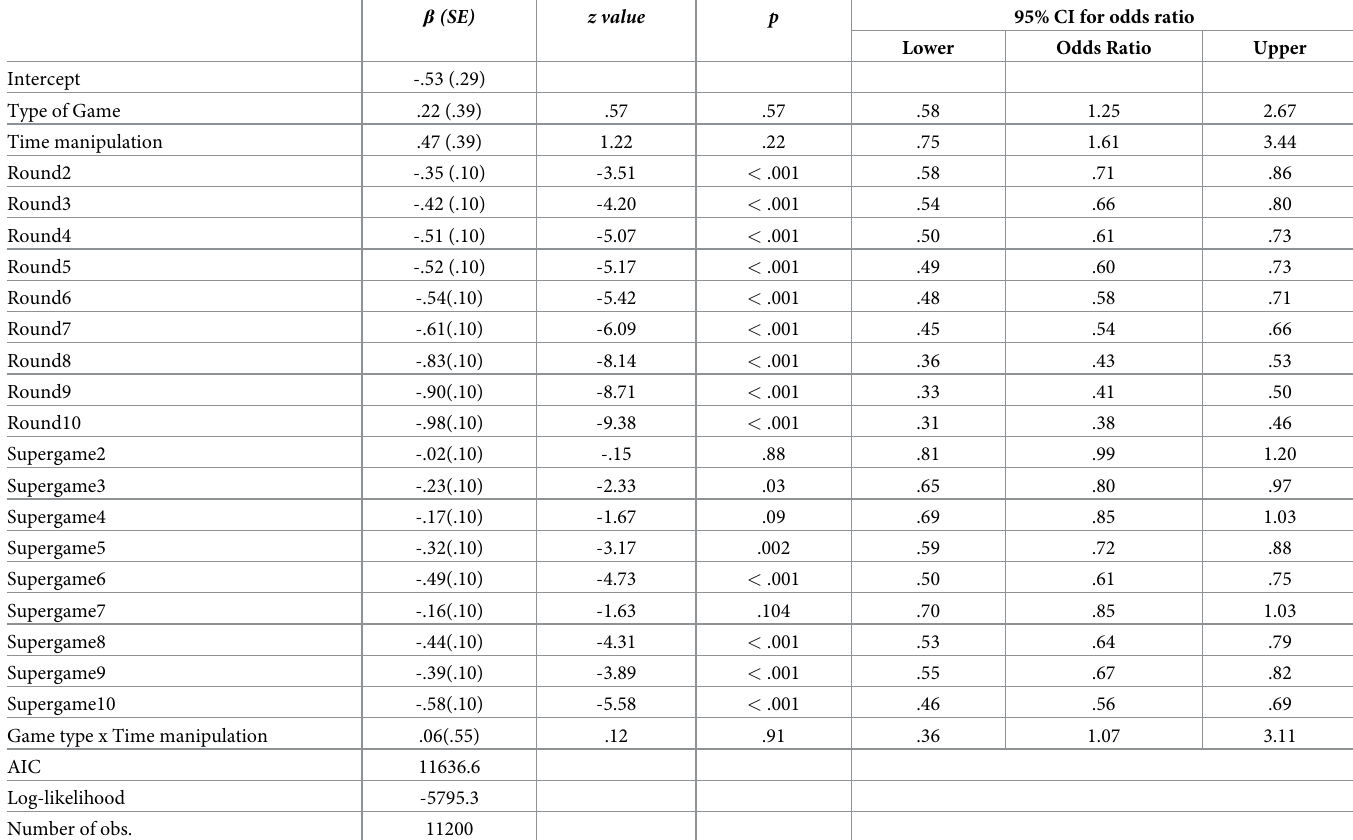
Table 6. Estimates of the logistic regression model for cooperation